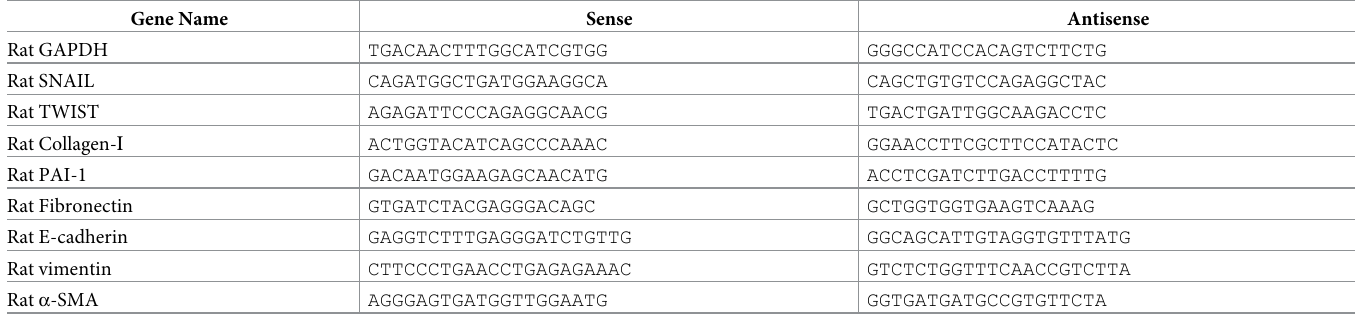
Table 1. Primers used in this